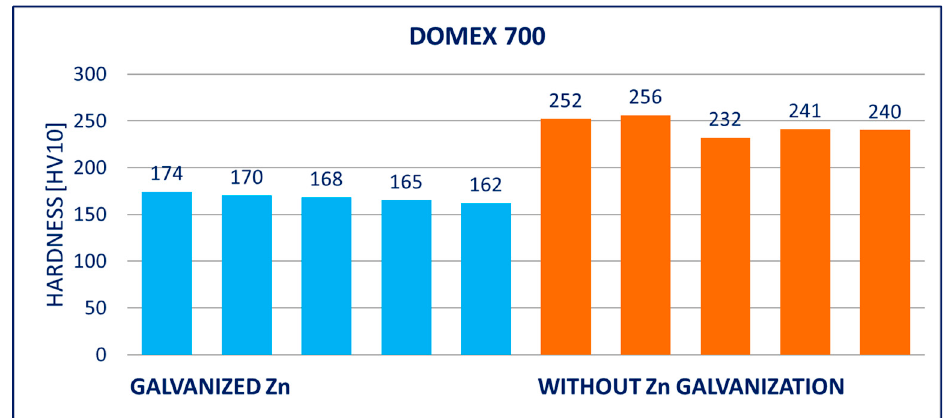
Figure 13. Results of hardness HV10 of specimens of DOMEX 700 steel.